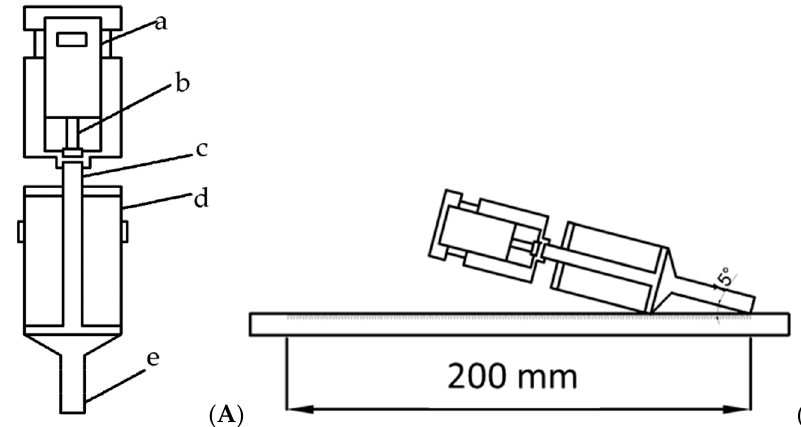
Figure 3. The digital display 3D printing extrudability tester.